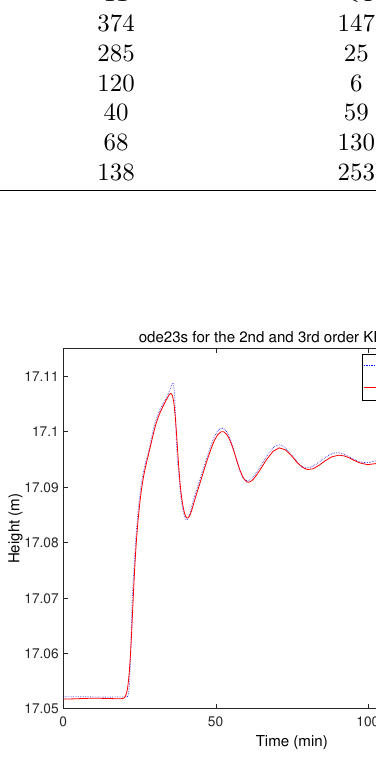
Figure 8: Exploded view of all fixed step-length solvers for 2 nd and 3 rd order KP scheme ( (cid:52) t = 0 . 25 s ).